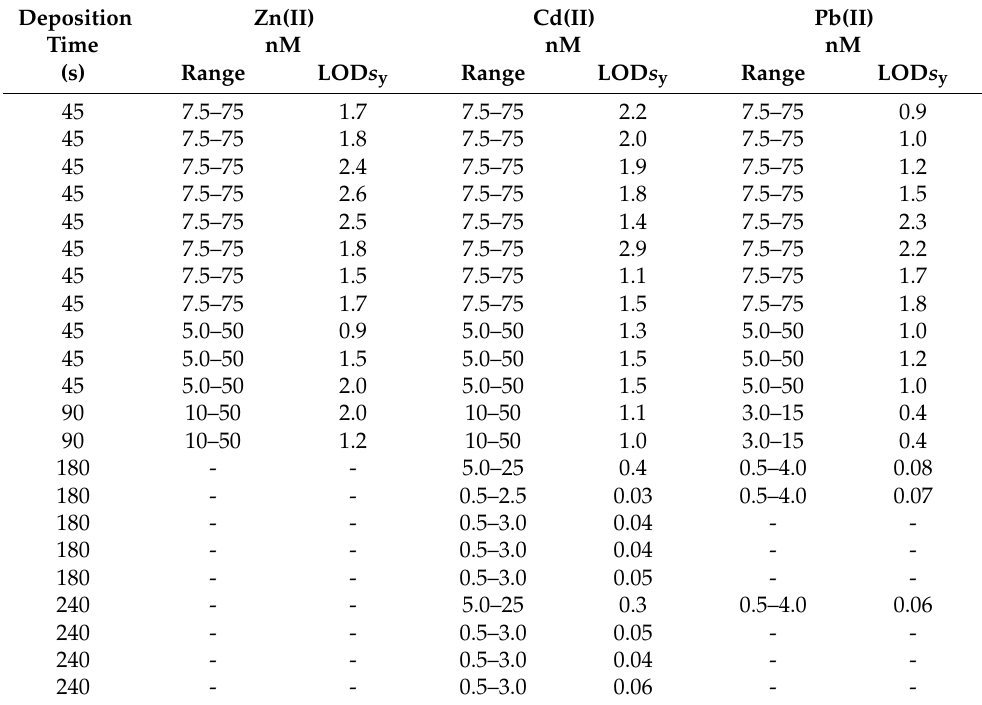
Table 1. Calibration LODs y for Pb(II), Zn(II) and Cd(II) in 10-mM NaNO 3 (pH